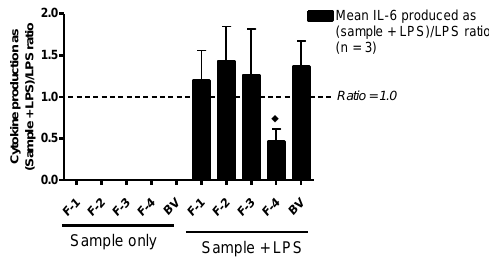
Figure 6. Effect of BV and its fractions with and without LPS on IL-6 production in PMA-differentiated U937 cells. The level of IL-6 produced by BV fractions alone was undetectable. However, in combination with LPS, Fractions F-1–F-3 and BV enhanced the level of cytokine produced by LPS though not significantly. Interestingly, F-4 significantly inhibited cytokine production by about 50% of the mean positive control (LPS) value ( n = 3).